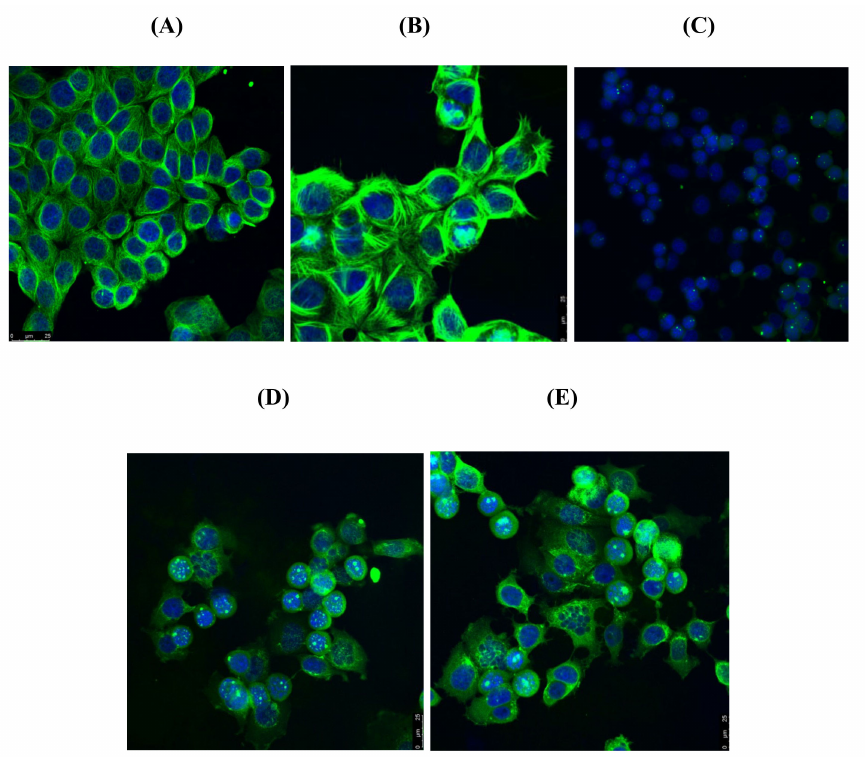
Figure 11. Compounds 19e and 21l depolymerise the microtubule network of MCF-7 breast can- cer cells. Cells were treated with ( A ) vehicle control (0.1% ethanol ( v / v )), ( B ) paclitaxel (1 µ M), ( C ) phenstatin ( 7a ) (1 µ M), ( D ) compound 19e (10 µ M), or ( E ) compound 21l (10 µ M) for 16 h. Cells were fixed in ice-cold methanol and stained with mouse monoclonal anti- α -tubulin–fluorescein isoth- iocyante (FITC) antibody (clone DM1A) (green), Alexa Fluor 488 dye, and counterstained with DAPI 4’-6’-diamidino-2-phenylindole (blue). Images obtained with Leica SP8 confocal microscopy, Leica application suite X software. Representative confocal micrographs of three separate experiments are shown. Scale bar indicates 25 µ